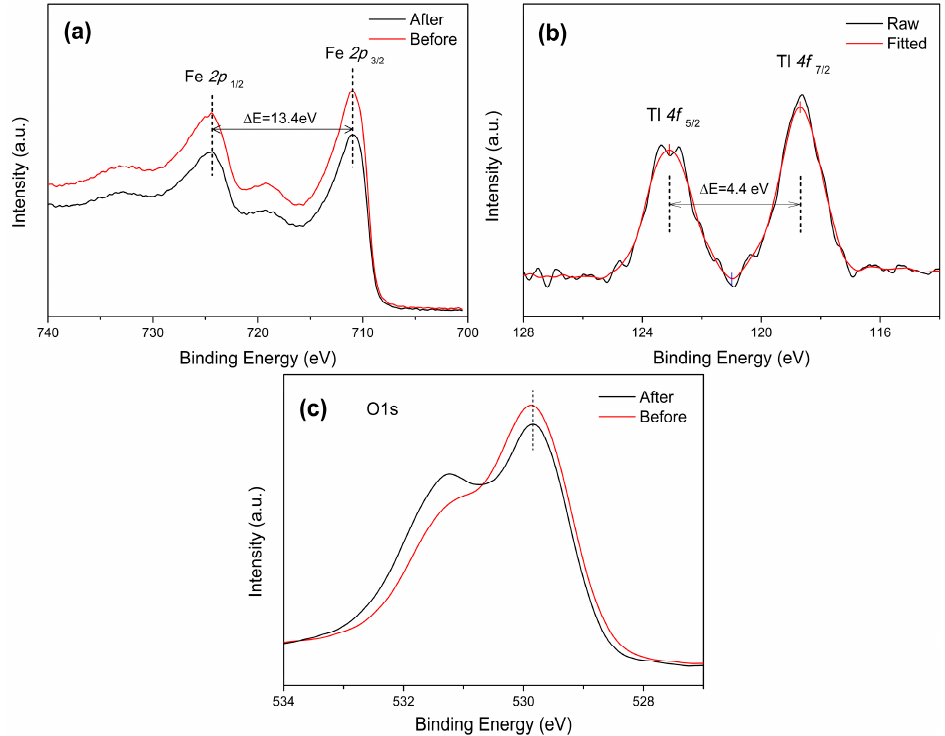
Figure 6. X-ray photoelectron spectroscopy (XPS) spectra of flocculent sludge obtained under applied current density of 16.7 mA/cm 2 at initial pH of 11: ( a ) Fe 2p core level; ( b ) Tl 4f core level; ( c ) O 1s core level.